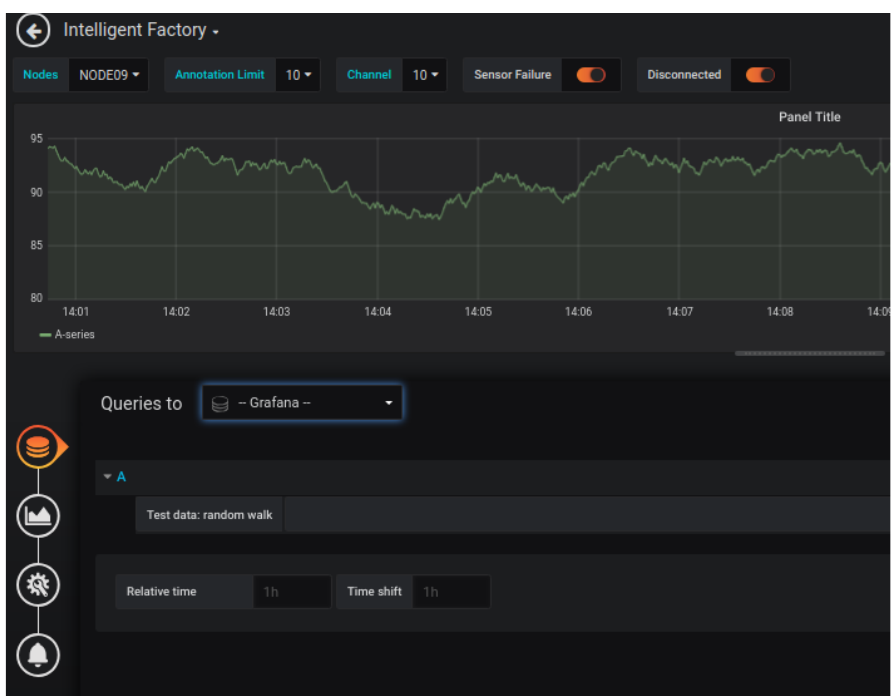
Figure 7. Example of observing historical data of a particular sensor. The graphical interface allows system administrators to configure different threshold-based warning levels, enabling push notifications that trigger actions to the support Figure 5. Graph showing measured values of sensors in Grafana. Figure 5. Graph showing measured values of sensors in Grafana.